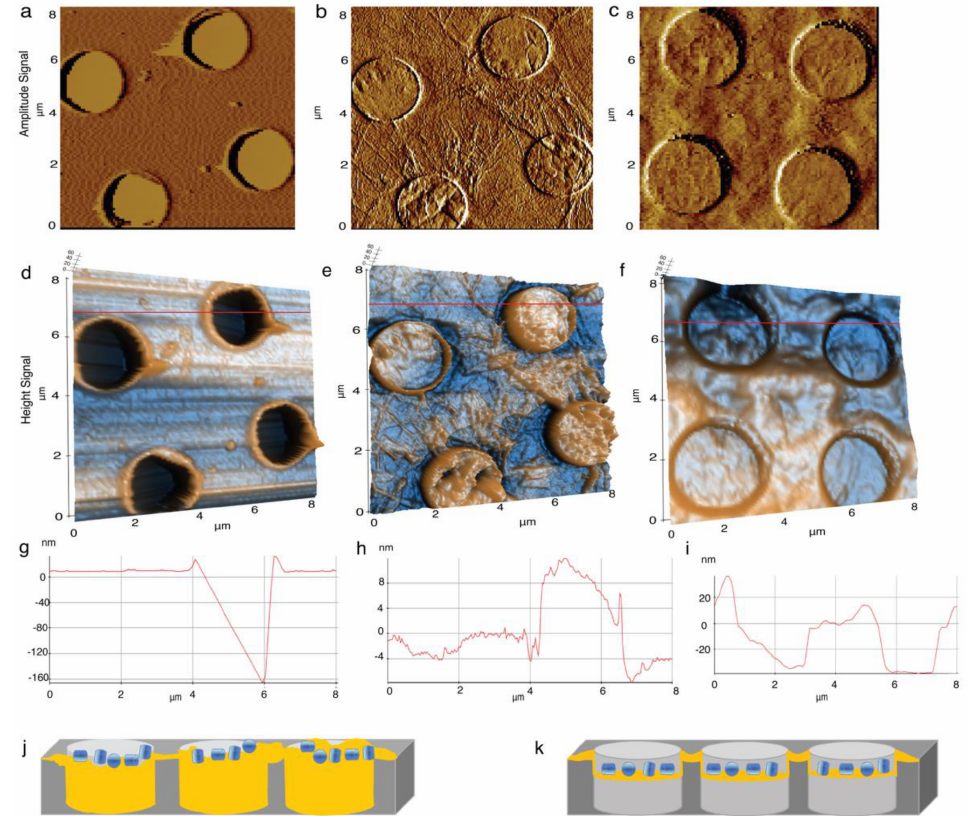
Figure 4. Elucidation of the surface property GO-Met-H 2 O and GO-H 2 O fabricated Cryo-EM